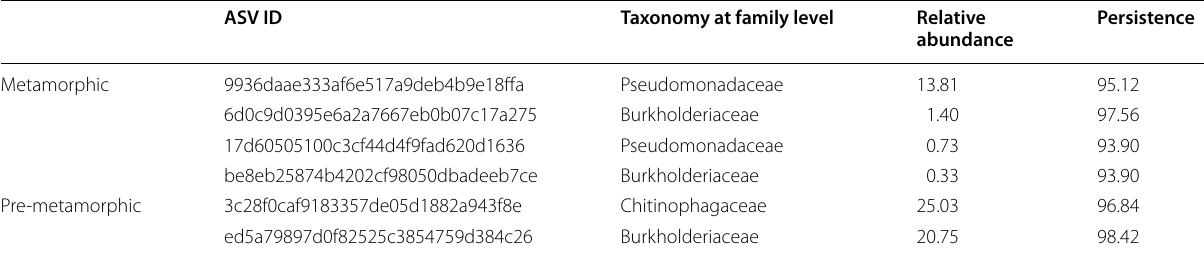
Table 2 Amplicon sequence variants (ASVs) defining the bacterial core of the microbiota of metamorphic and pre‑metamorphic A. altamirani